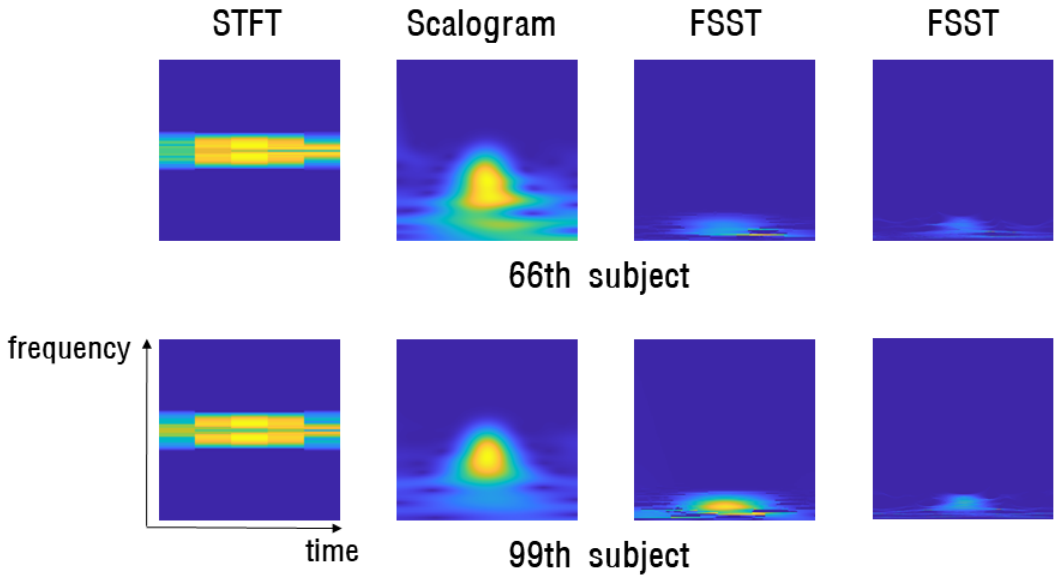
Figure 19. Accuracy of LSTM-based personal identification.